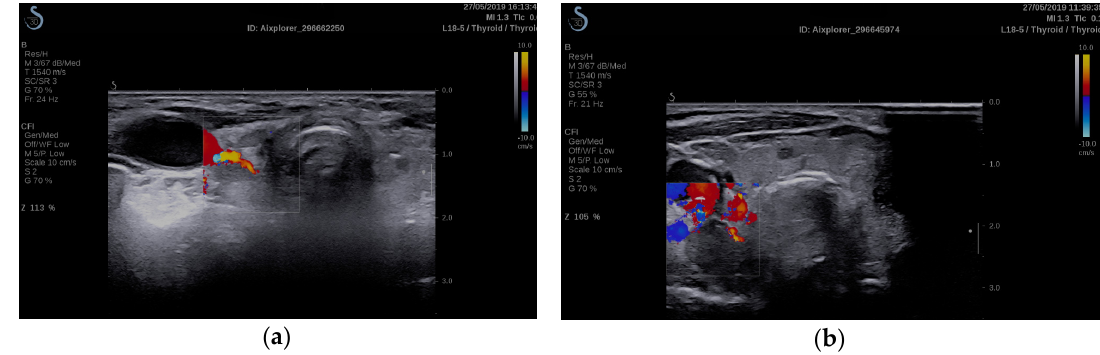
Figure 1. ( a ) 2B-Mode ultrasound evaluation of nodular goiter, visualizing parathyroid hyperplasia and thyroid nodule; ( b ) 2B-Mode ultrasound evaluation of autoimmune thyroiditis, visualizing parathyroid